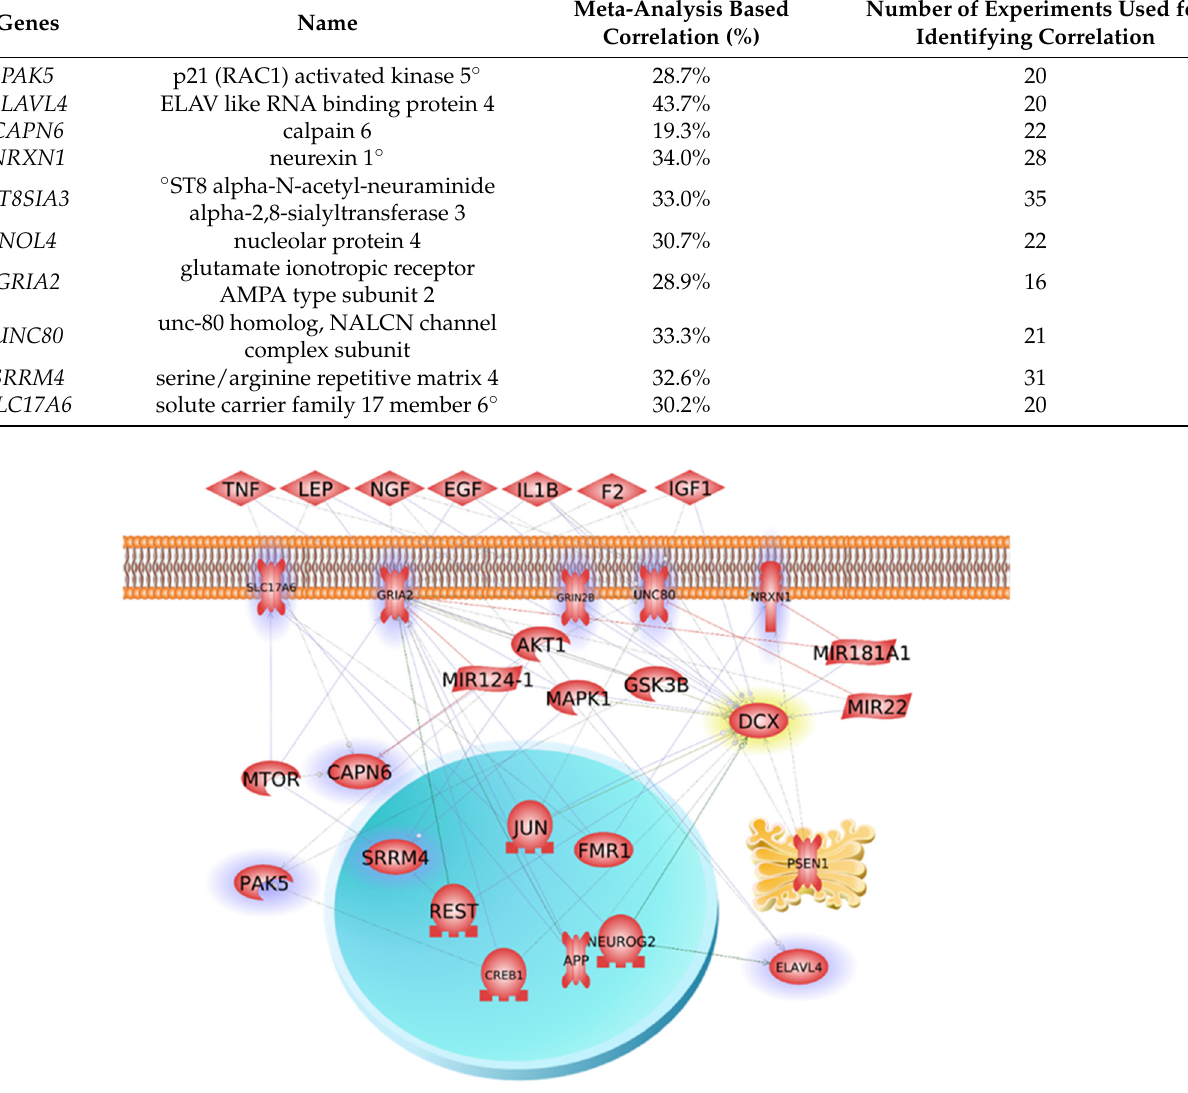
Table 2. Top 10 coexpressed genes with DCX revealed by meta-analysis of publicly available transcriptomic data. Genes